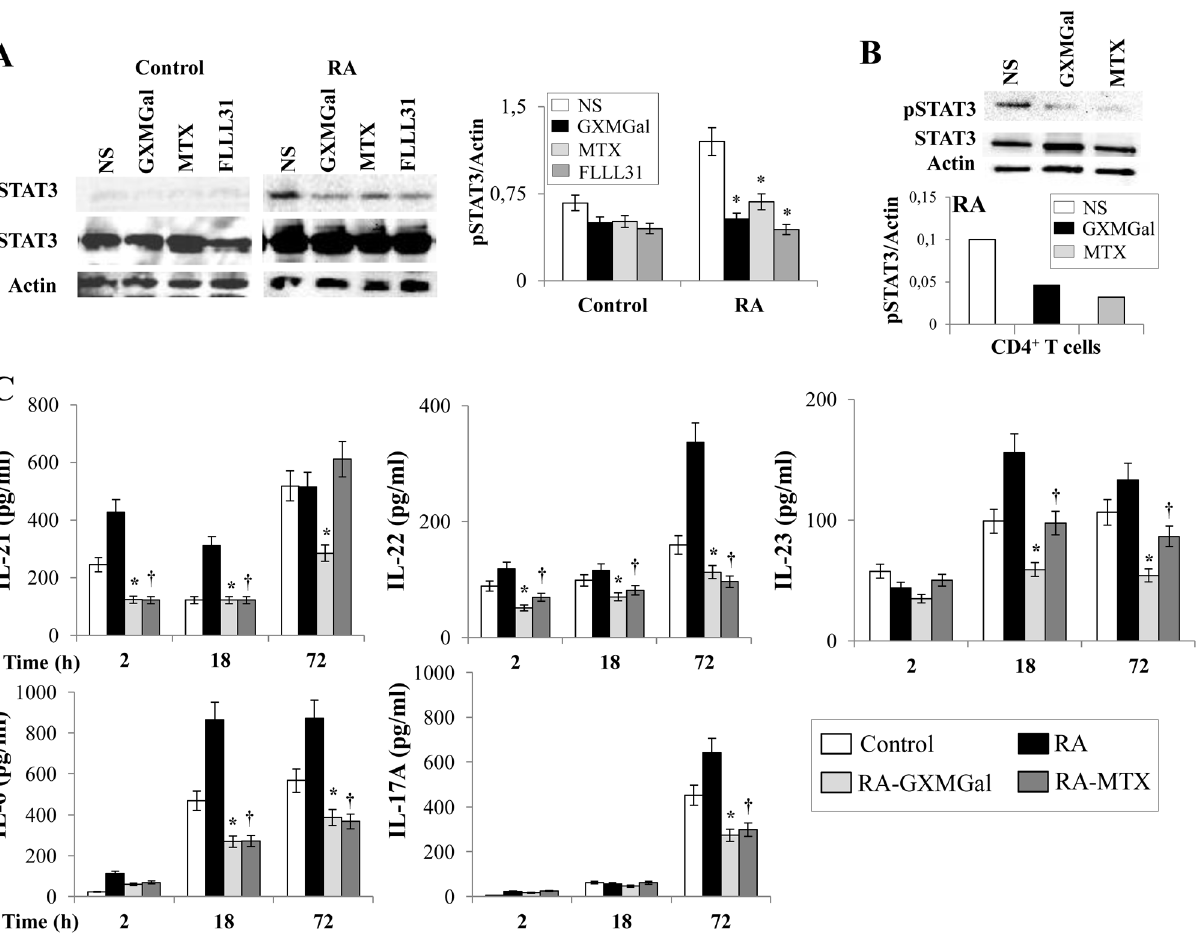
Figure 6. GXMGal effect on Th17 response. Activated PBMC ( A and C ) or purified CD4 + T cells ( B ) (both 5 6 10 6 /ml) from Control and RA were incubated for 2, 18 and 72 h in the presence or absence (NS) of GXMGal (10 m g/ml), MTX (10 ng/ml) or FLLL31 (5 m M). After 18 h of incubation, cell lysates were analyzed by western blotting. Membranes were incubated with Abs to pSTAT3 and STAT3. Actin was used as an internal loading control. Normalization was shown as mean 6 SEM of five independent experiments ( A ) or as one representative experiment of three with similar results ( B ). *, p , 0.05 (triplicate samples of 5 different Control and RA; RA treated vs untreated cells). Culture supernatants were collected after 2, 18 and 72 h to test IL-21, IL-22, IL-23, IL-6 and IL-17A levels by specific ELISA assays. *, p , 0.05 (triplicate samples of 7 different Control and RA; RA GXMGal-treated vs untreated cells); { , p , 0.05 (triplicate samples of 7 different Control and RA; RA MTX-treated vs untreated cells) ( C ).